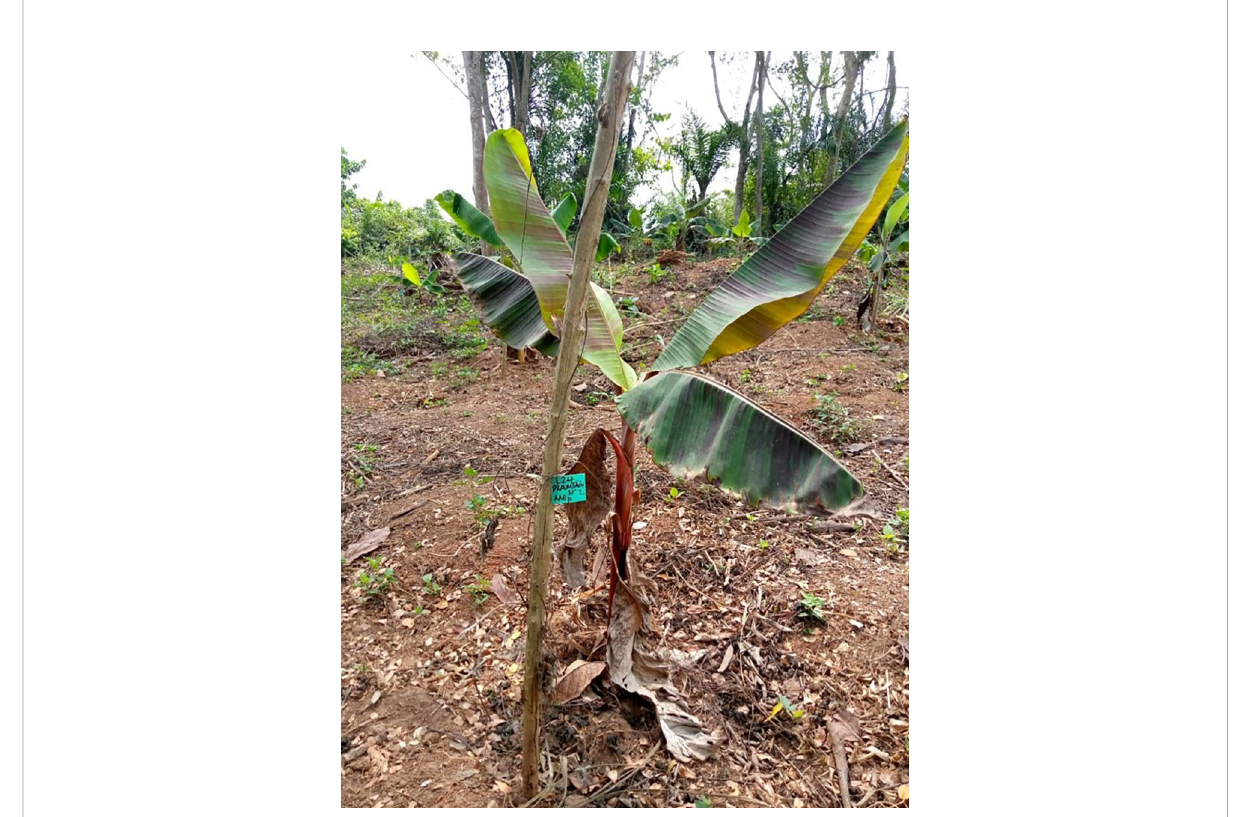
FIGURE 3 Banana plant (accession plantain N2) affected by water de fi cit with higher atmospheric temperature in Cameroon. Leaves turn yellow color before wilting if drought